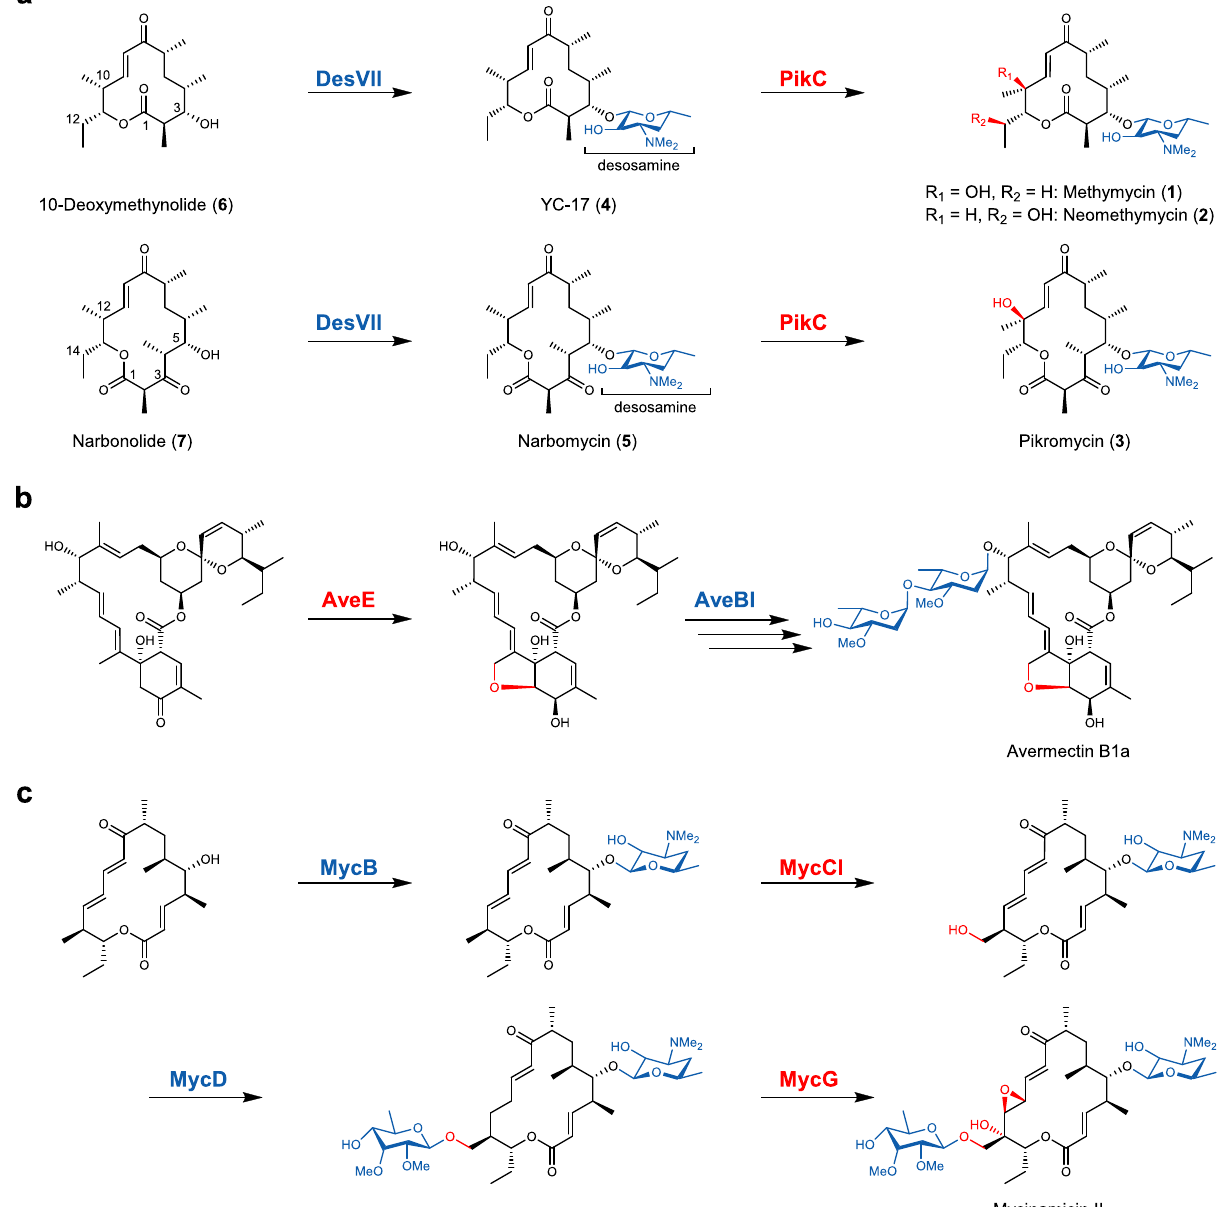
Fig. 1| Representativemacrolidebiosyntheticpathways. a Thelatepikromycin/ (neo)methymycinbiosyntheticpathwayinwhichtheglycosyltransferase-mediated sugar attachment precedes the P450-catalyzed hydroxylation. b The partial aver- mectin biosynthetic pathway with an order of oxidation-glycosylation. c The post-